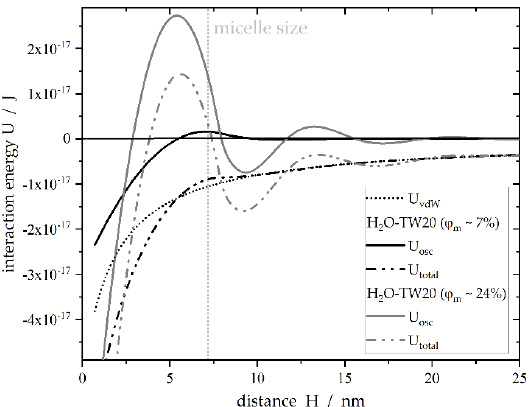
Figure 1. Simulated interaction energy of two spherical droplets with the distance 𝐻 according to Trokhymchuk et al. [32] and Basheva et al. [13]. It is assumed that the film between the droplets contains hard, spherical micelles. Parameters used for calculation are summarized in Table 1. The volume fraction of the micelles in the continuous phase 𝜑 (cid:3040) for a given aqueous surfactant concen- tration 𝑐̃ (cid:3021)(cid:3024)(cid:2870)(cid:2868)(cid:3009)(cid:2870)(cid:3016) was approximated with a linear expression according to data obtained by Basheva et al. [13]: 𝜑 (cid:3040) = 1.7 × 10 (cid:2879)(cid:2871) 𝑚 (cid:2871) 𝑚𝑜𝑙 (cid:2879)(cid:2869) ⋅ 𝑐̃ (cid:3021)(cid:3024)(cid:2870)(cid:2868)(cid:3009)(cid:2870)(cid:3016) . Table 1. Parameters used for calculation of the total interaction energy 𝑈 .